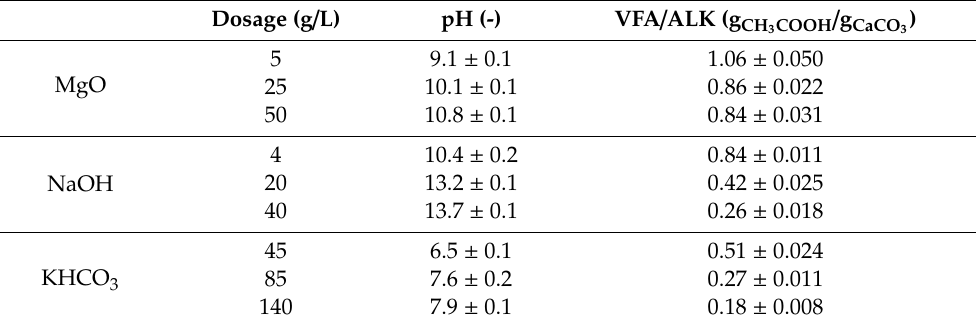
Table 3. pH and volatile fatty acids / alkalinity (VFA / ALK) ratio after leachate